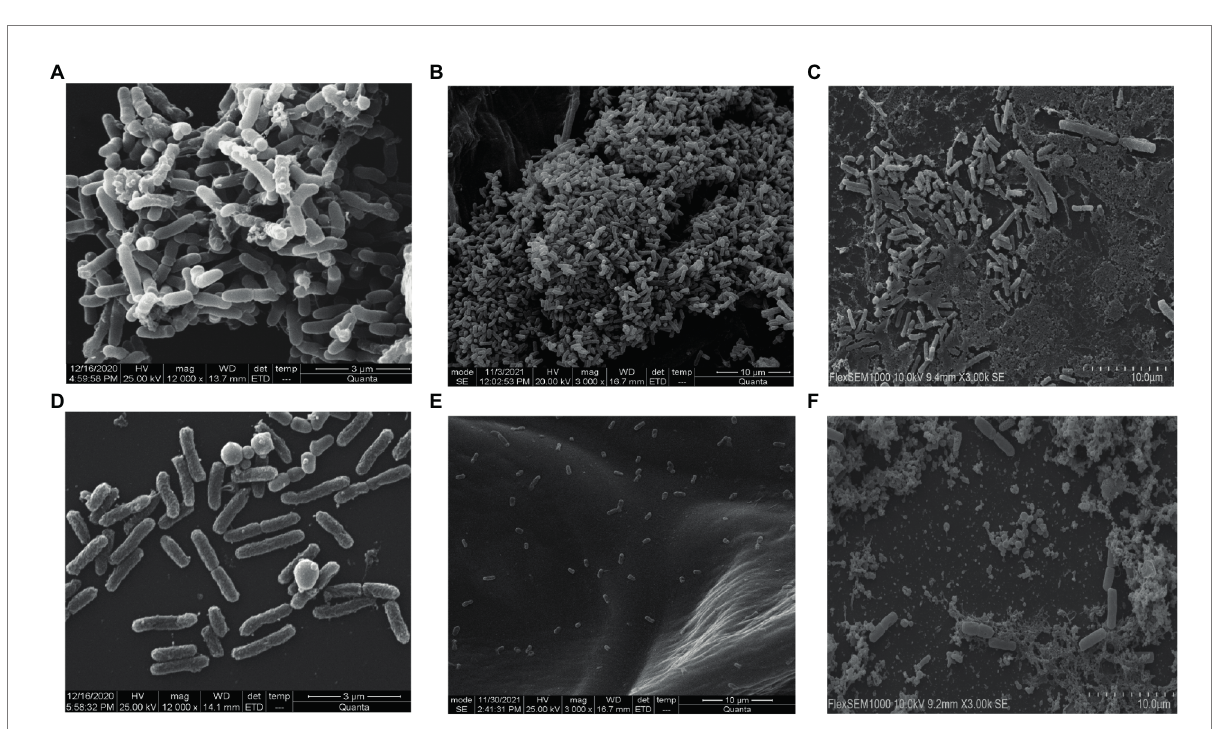
FIGURE 4 Scanning electron micrographs of Salmonella typhi biofilm formation and degradation assay. (A, C, E) show 24 h biofilm on coverslip, onion and in milk, respectively. (B, D, F) reveal the effect of bacteriophage STWB21 on biofilms formed on coverslip, onion and in milk,